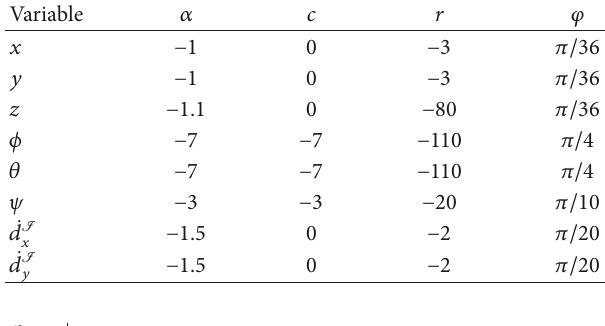
Table 2: Closed-loop pole placement requirements for the NLLS-2L controller.